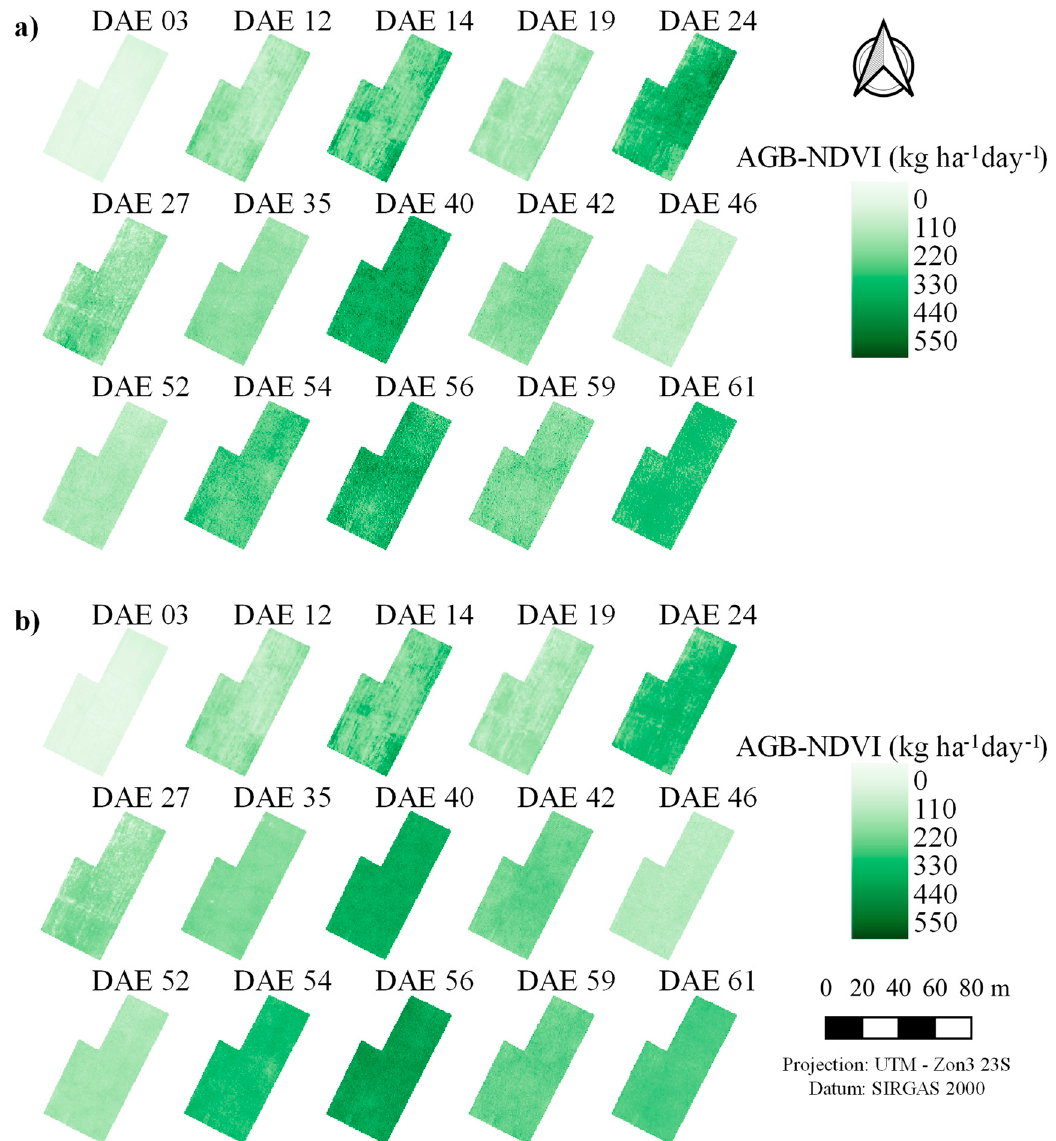
Figure 10. Spatial and temporal variability of the daily increase in aboveground dry biomass derived from the NDVI ( a ) and SAVI ( b ).